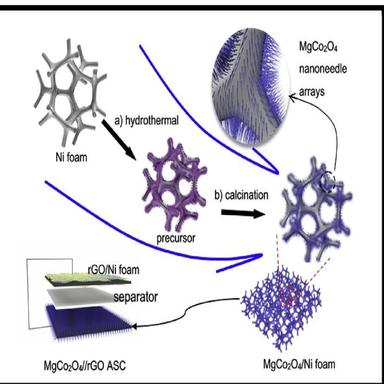
The Schematic illustrations of the MgCo2O4 nanoneedle arrays/Ni foam substrate.